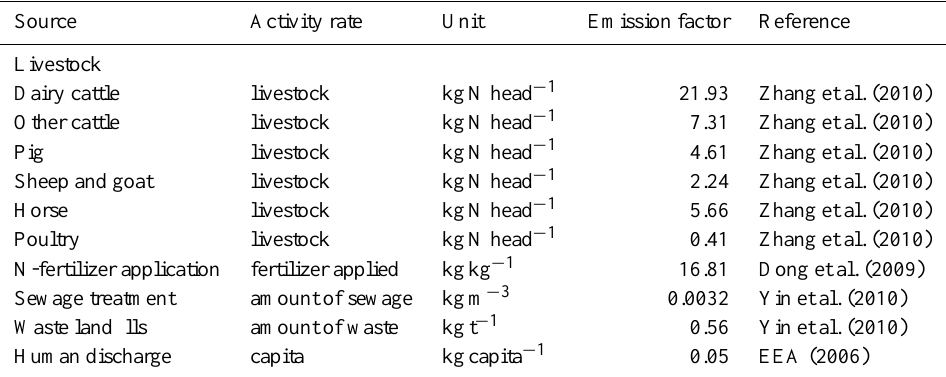
Table 5. Emission factors of anthropogenic ammonia emission